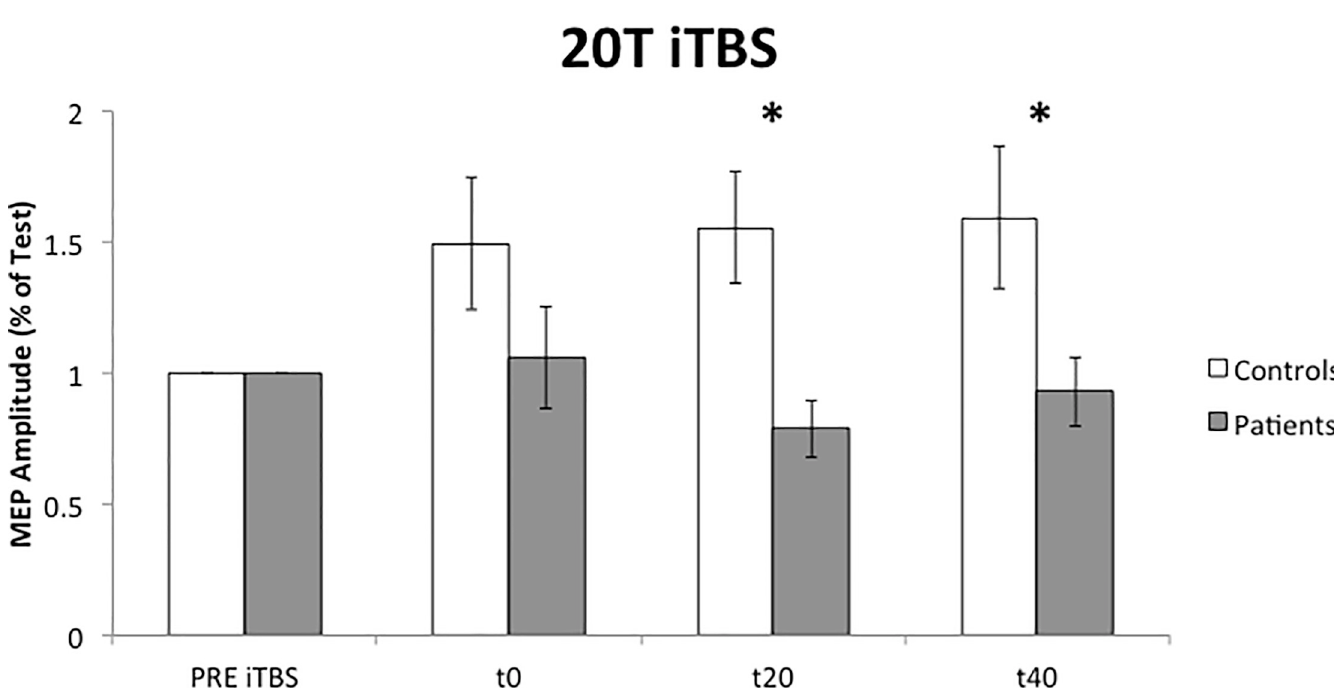
Fig 3. Effects of cerebellar iTBS on cortical excitability (MEP protocol). 20T: 20 Test. PRE: before iTBS; t0: immediately after iTBS; t20: 20 minutes after iTBS; t40: 40 minutes after iTBS. � : P < 0.05. Error bars represent the standard error.